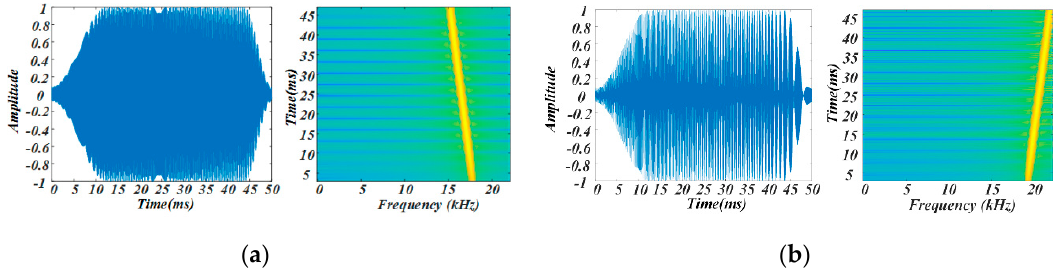
Figure 3. Waveform illustrations of chirp signals. ( a ) 18–15 kHz chirp signal; ( b ) 19–22 kHz chirp signal.